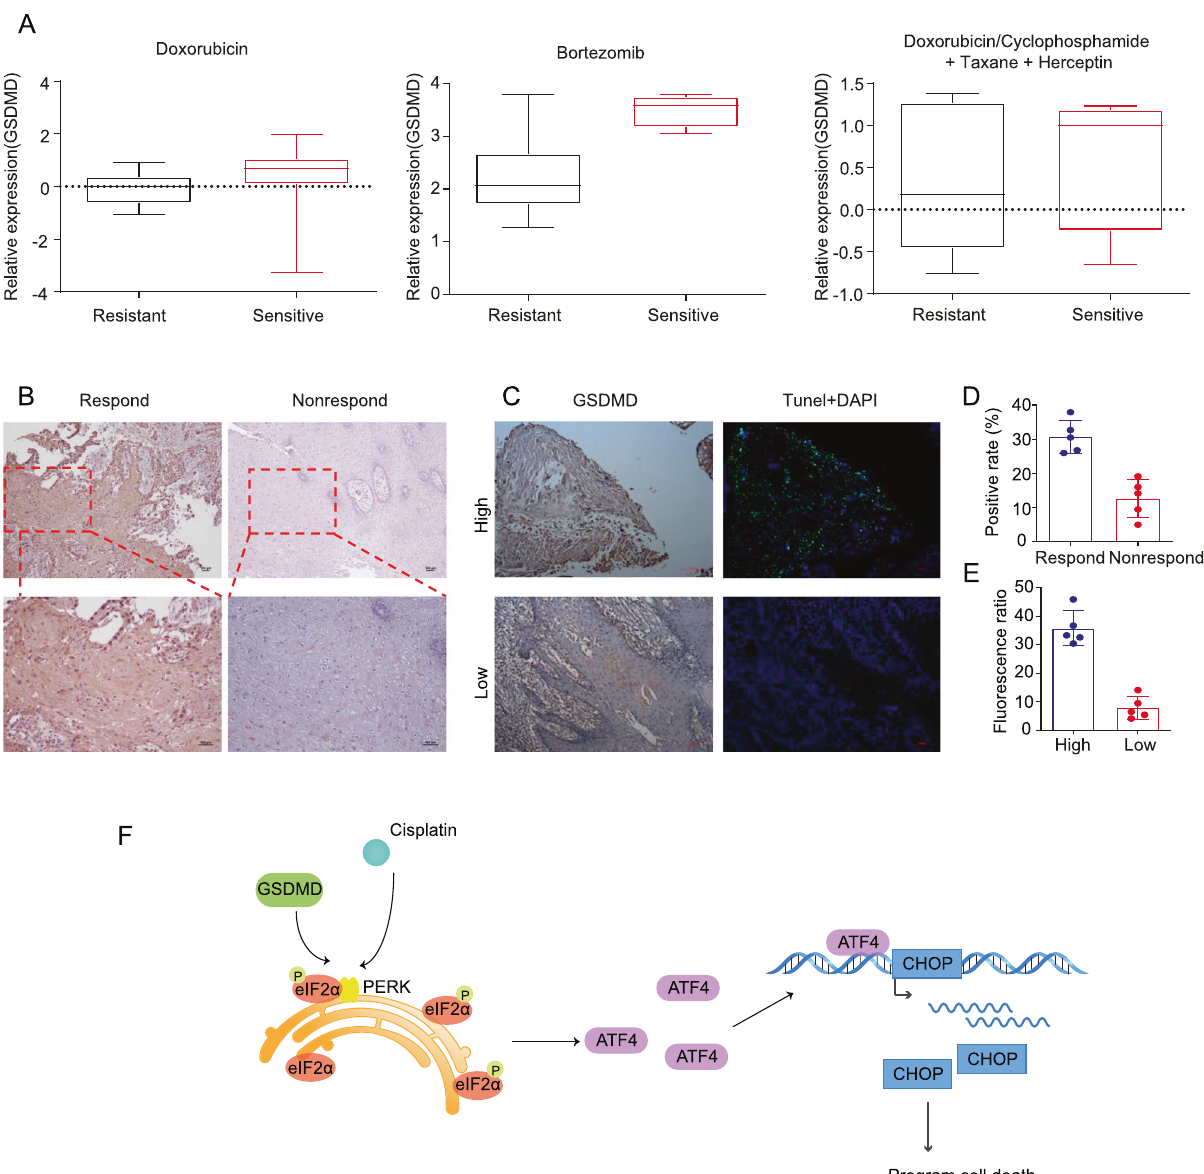
Fig. 7 GSDMD expression and apoptosis detection in patient samples after neoadjuvant chemotherapy. A Data from the ONCOMINE database showed that patients with high expression of GSDMD are more sensitive to drugs, including doxorubicin, bortezomib and cisplatin, than those with low expression. B Representative pictures show that samples from patients with a good response to neoadjuvant chemotherapy have higher expression of GSDMD than those with a poor response. C TUNEL staining and immunohistochemical staining of serial sections was performed, DAPI staining was used to indicate the cell nucleus. D The statistical results of the positive rate of GSDMD immunohistochemical staining in neoadjuvant chemotherapy-patient samples showed that patients with a good response had higher GSDMD expression ( n = 10). E Statistics show that the group with higher expression of GSDMD has higher green fl uorescence. F Proposed working model showing that GSDMD can enhance the intercalation between PERK and eIF2 α , promote phosphorylation of eIF2 α and thus increase ER-stress response and cisplatin